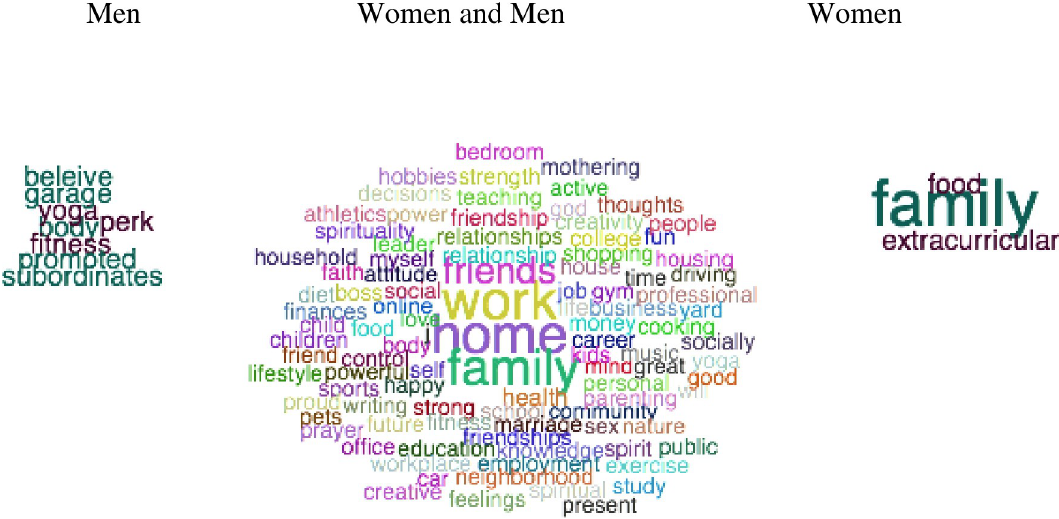
Fig 5. Word clouds describing domains where you sense that you have power. Note . The figures were created using the same method as in Fig 4, but based on word data answering the semantic questions “Please write five words describing domains in your life where you sense that you have